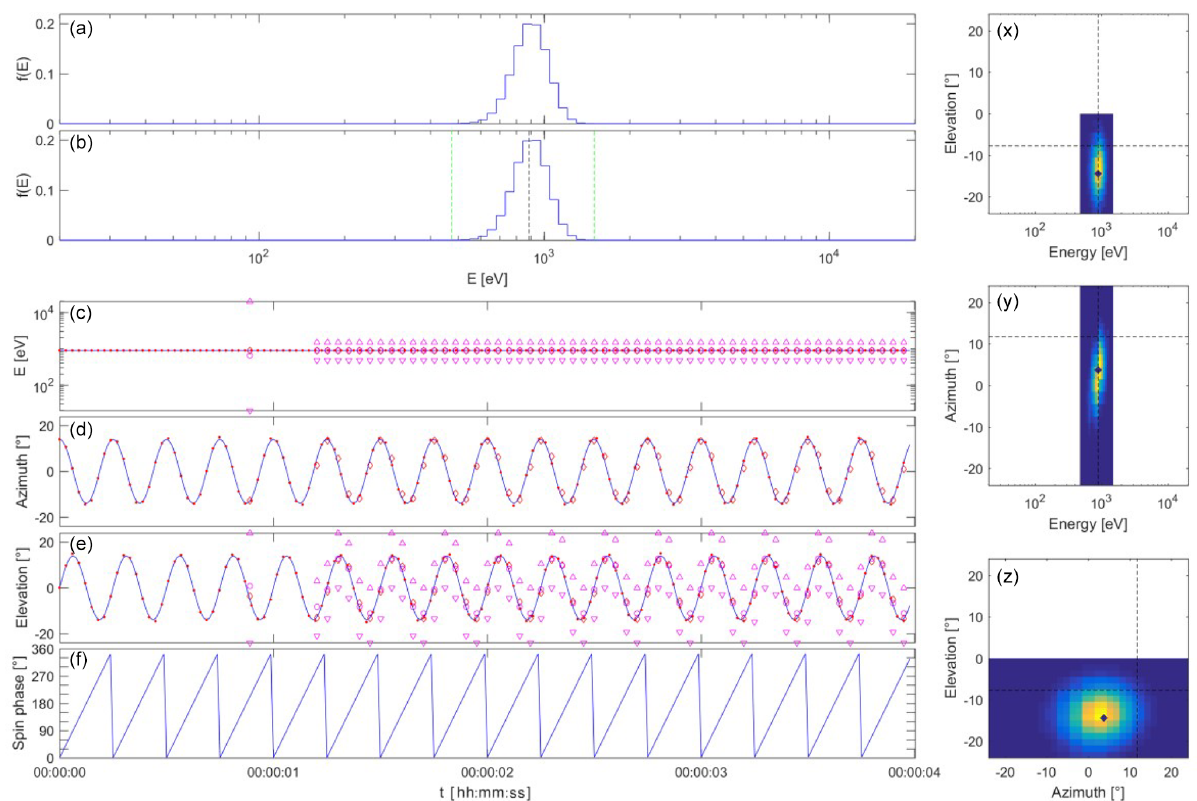
Figure 3. Plasma spectrometer measurements of a constant solar wind beam from a spacecraft with spin period t spin = 0 . 25s. The plot layout is the same as that of Fig.